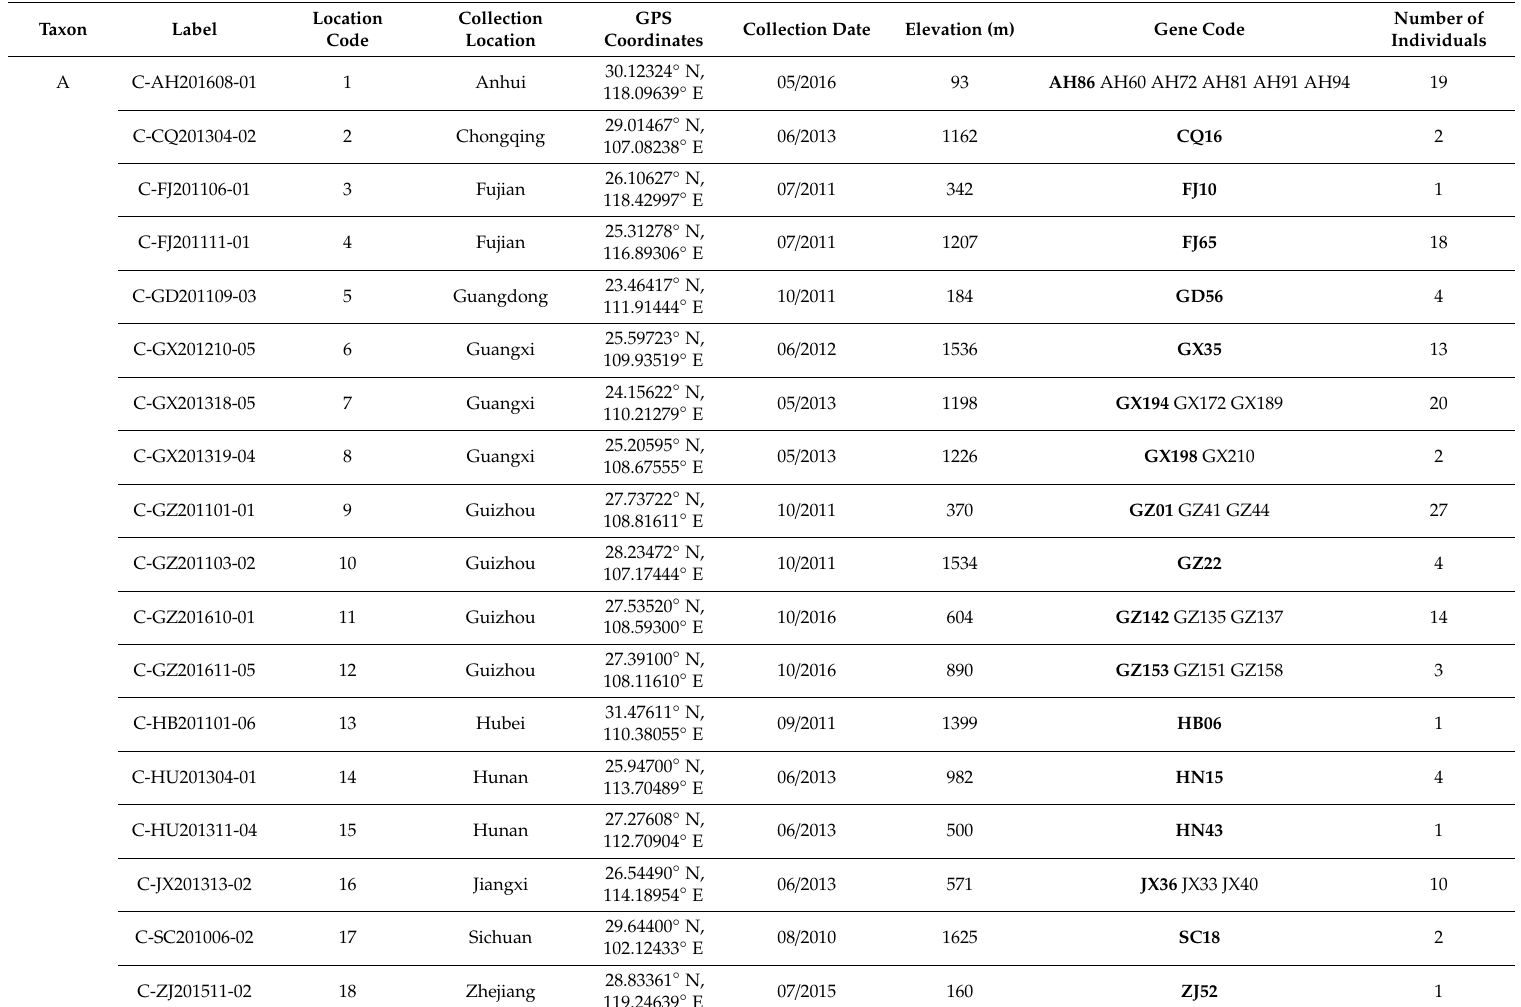
Table 1. Collection data and information on A. triastriatus sequenced in this study using the COI gene. The code in bold formatting was sequenced using 7 genes.